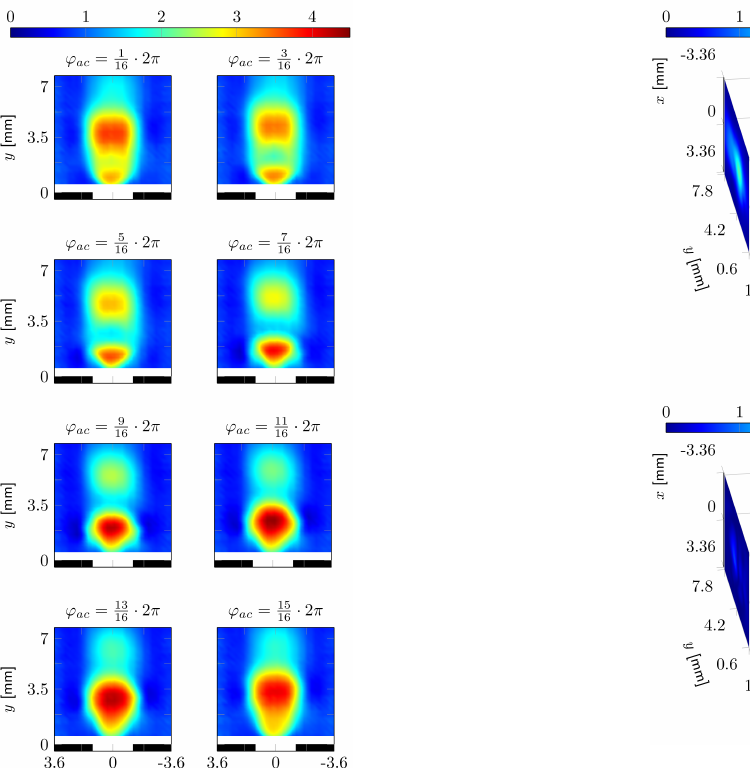
Figure 11. Amplitude of the sound-excited flow velocity oscilla- tions (a) in y direction and (b) in z